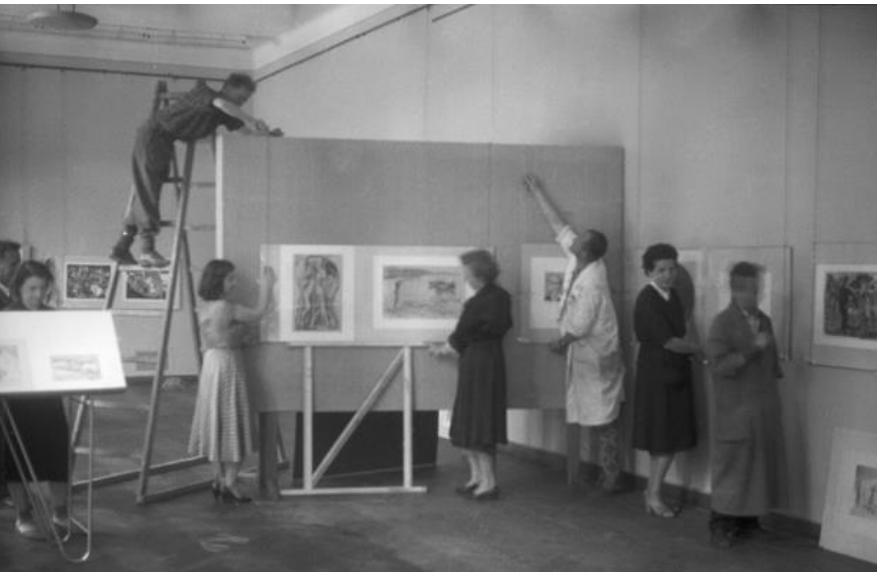
Figure 1. 1st International Exhibition of Graphic Arts, Moderna galerija, Ljubljana, 1955 Installing the exhibition, © Moderna galerija.